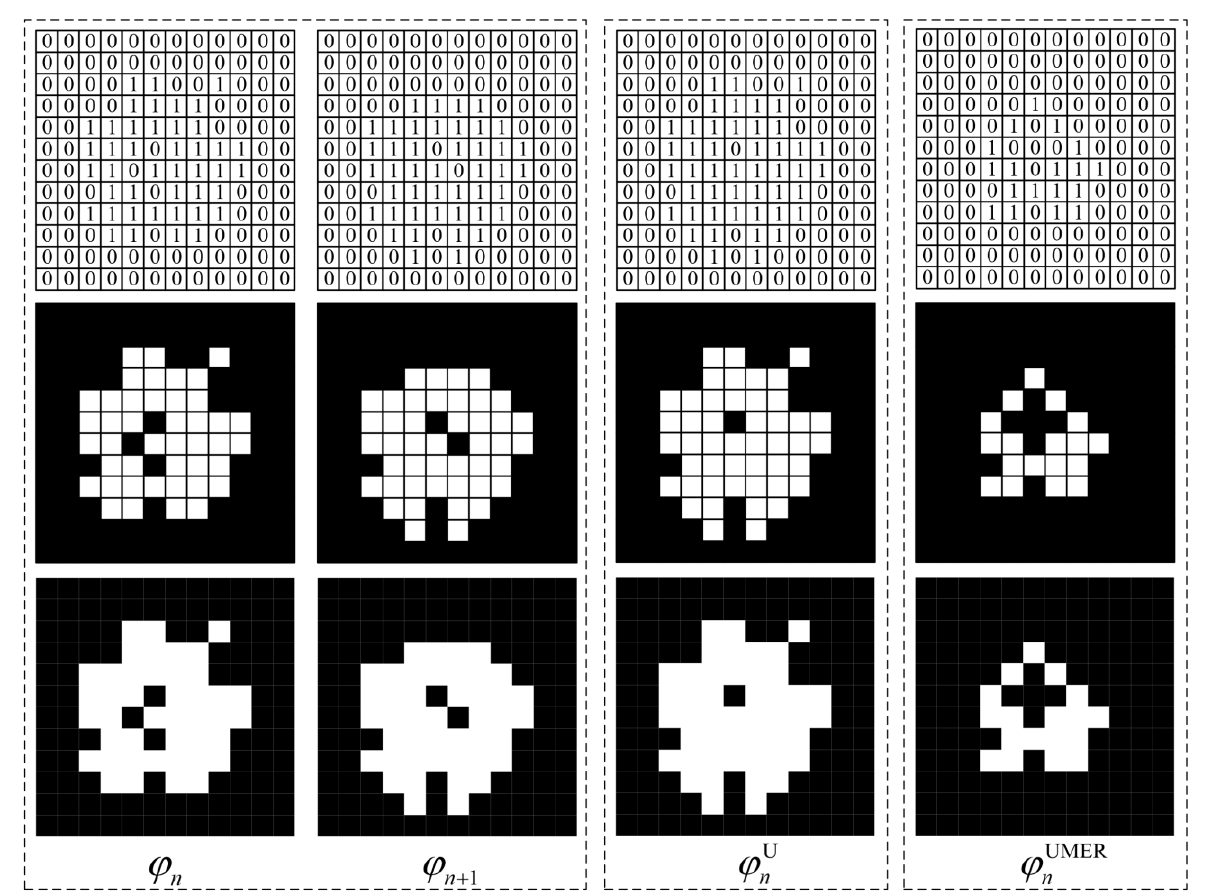
Figure 4. Schematic diagram of Algorithm 2 (UMER).